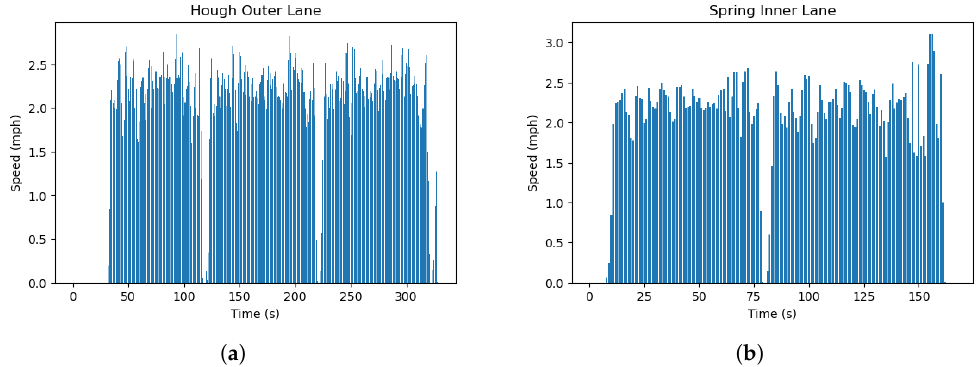
Figure 25. The speed time graphs for Spring algorithm run on the inner lane and Hough algorithm on the outer lane are shown in the above images. For more graphs of the algorithms, please refer to Appendix